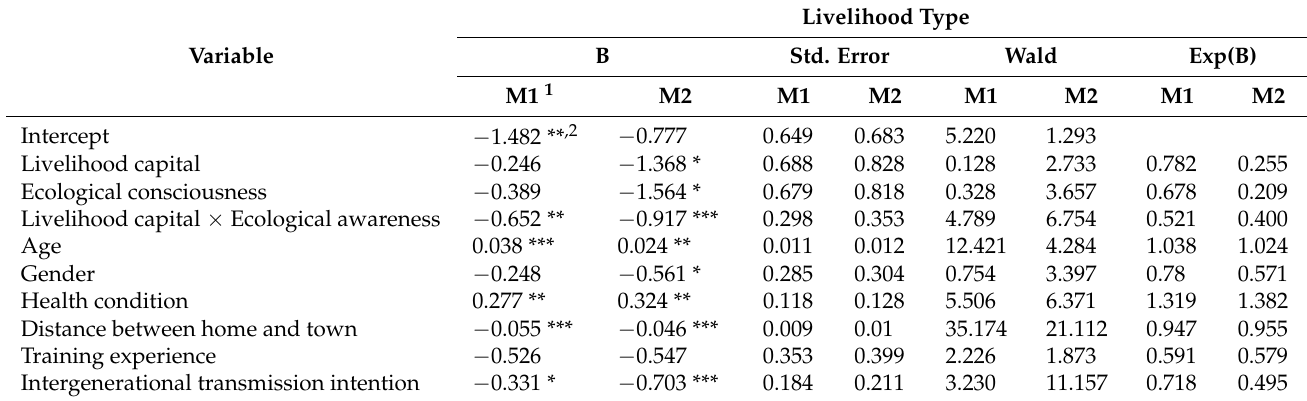
Table 5. Results of the moderating effect of ecological